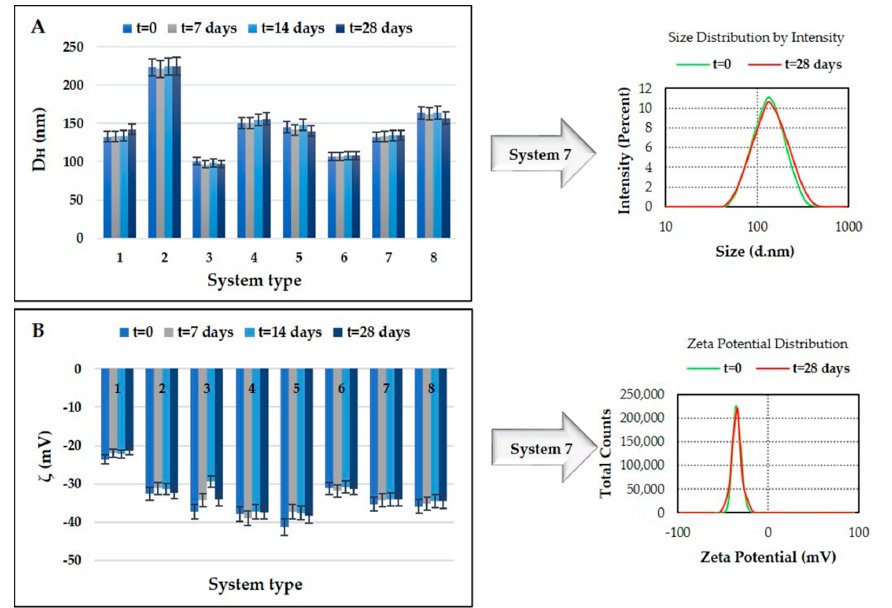
Figure 4. Influence of the storage time on ( A ) mean particle size (D H ) and ( B ) zeta potential ( ζ ) for all the samples after extrusion and homogenization processes.